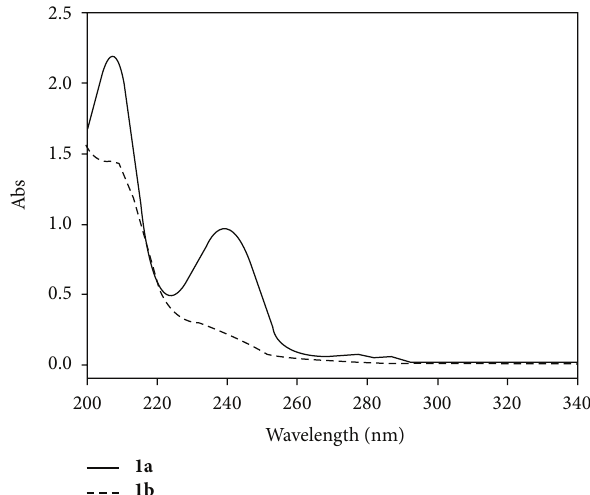
Figure 3: UV-vis spectra of 1a and 1b in H 2 O/CH 3 CN (1: 1v/v) (5 × 10 −5 M).